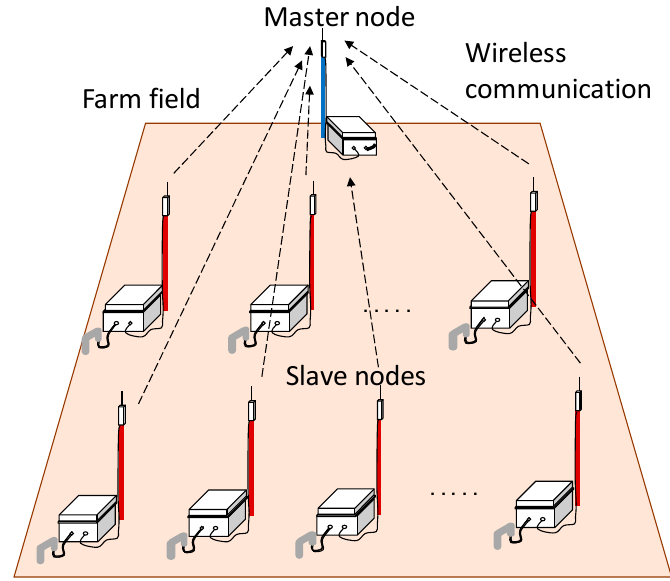
Figure 3. Scheme of the sensor network system with the developed soil moisture sensors.